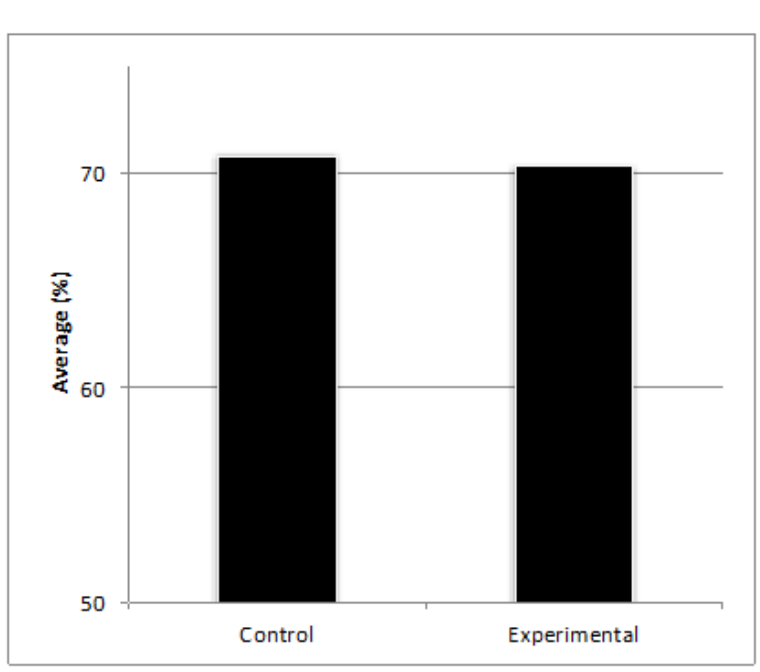
Figure 8. The overall averages for both the control and experimental group for the pre-quizzes